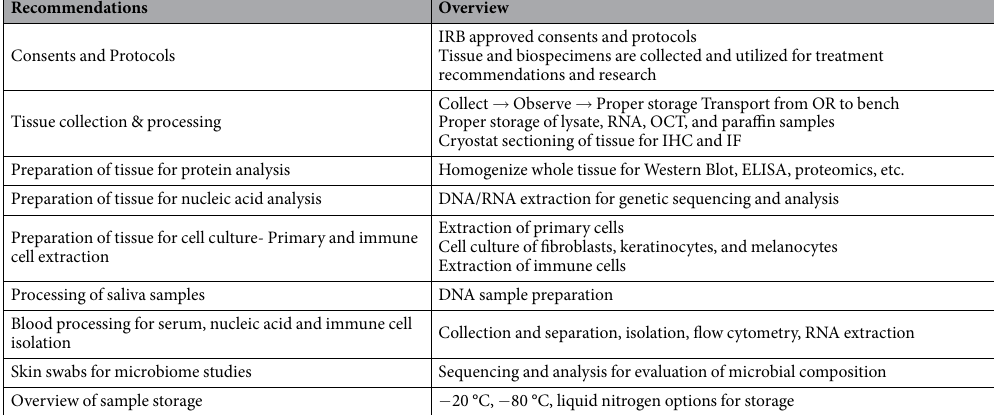
Table 2. Recommendations for tissue and biospecimen